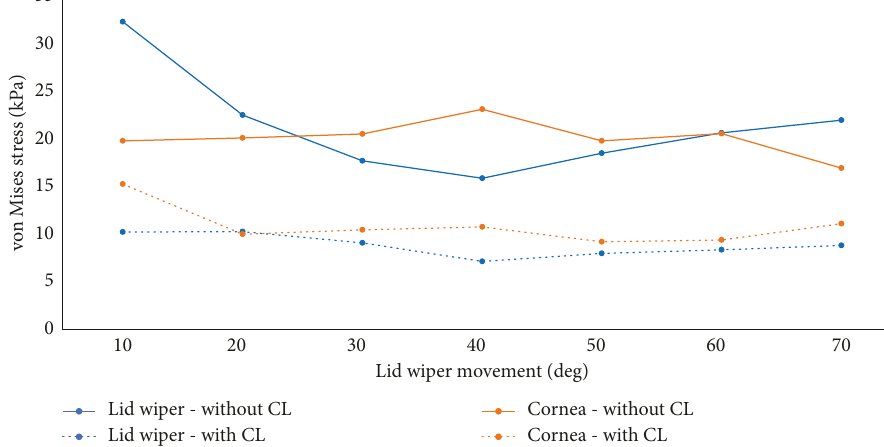
Figure 6: Von Mises stress (kPa) in the lid wiper and cornea during blink without and with CL when the lid wiper is moved at different positions from superior (10 ° ) to inferior cornea (70 ° ) (value of the data labels shows von Mises stress; unit: kPa). Graph drawn with Microsoft Excel 2019